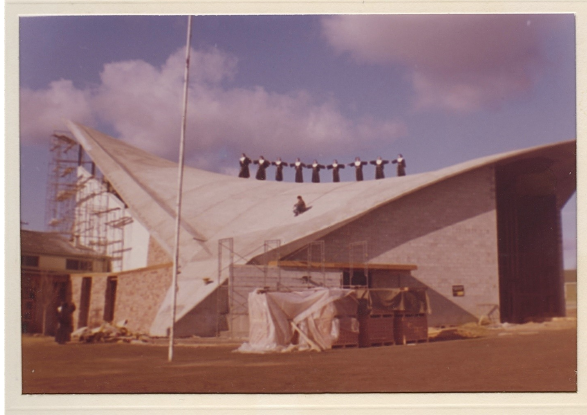
Figure 9: Scaffolding and progression of